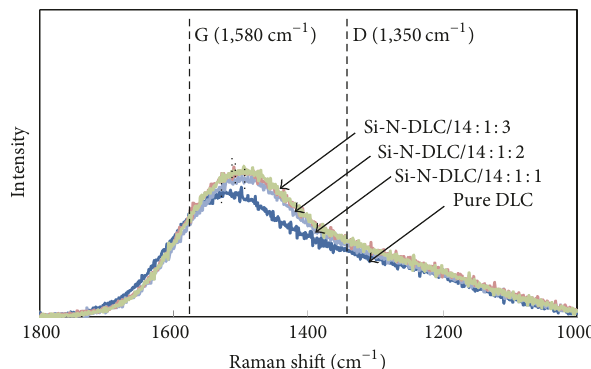
Figure 3: Raman spectra of the DLC and Si-N-DLC films at various flow rate